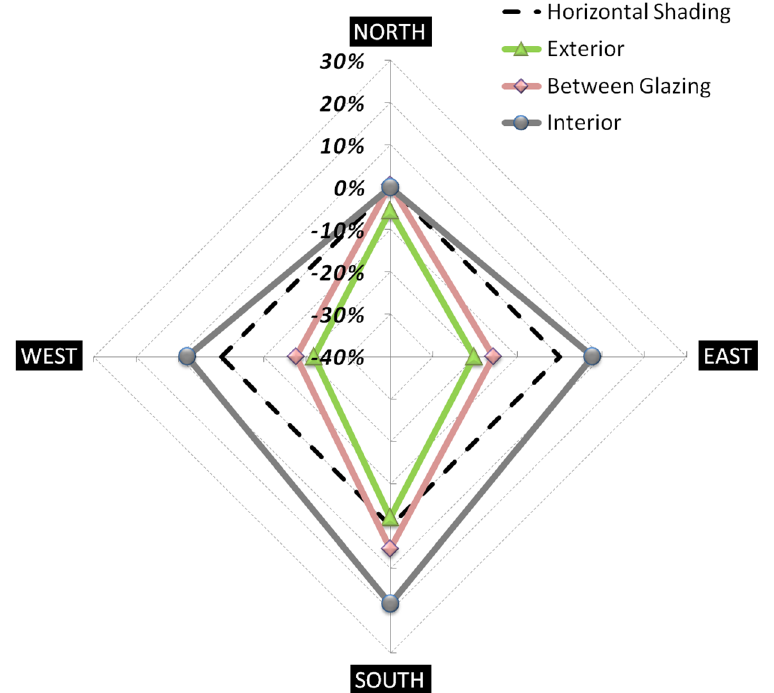
Figure 10. Saving ratio of heating and cooling load according to the type of shading ( WWR 60%, U-value: 2.1, SHGC: 0.4).